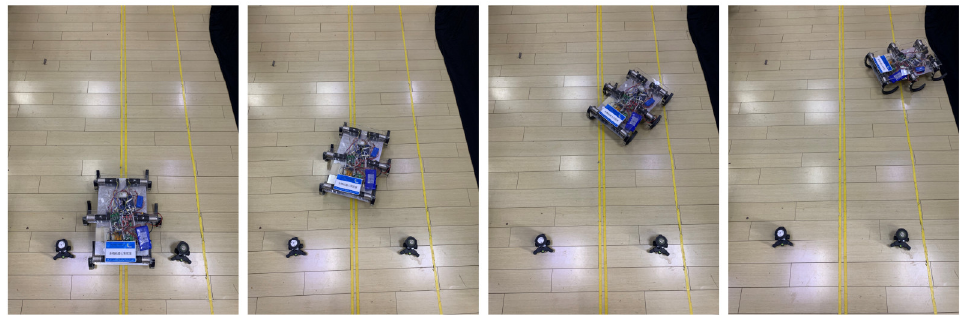
Figure 11. Turning experiment process of robot.